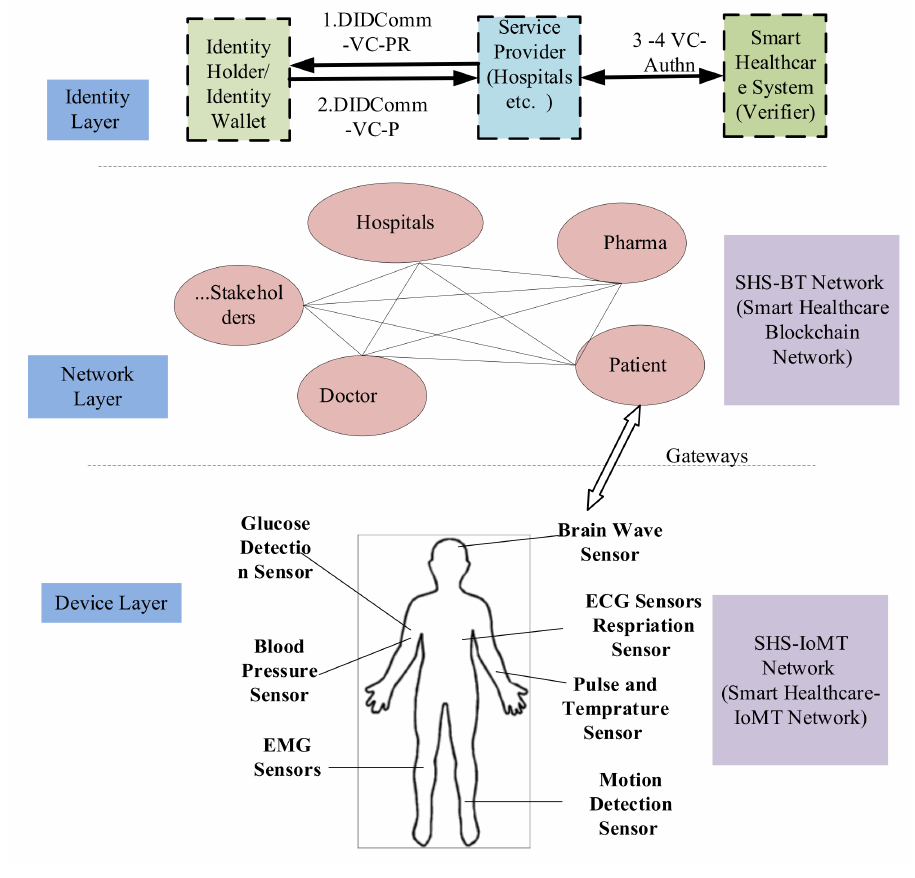
Figure 3. SSI-SHS